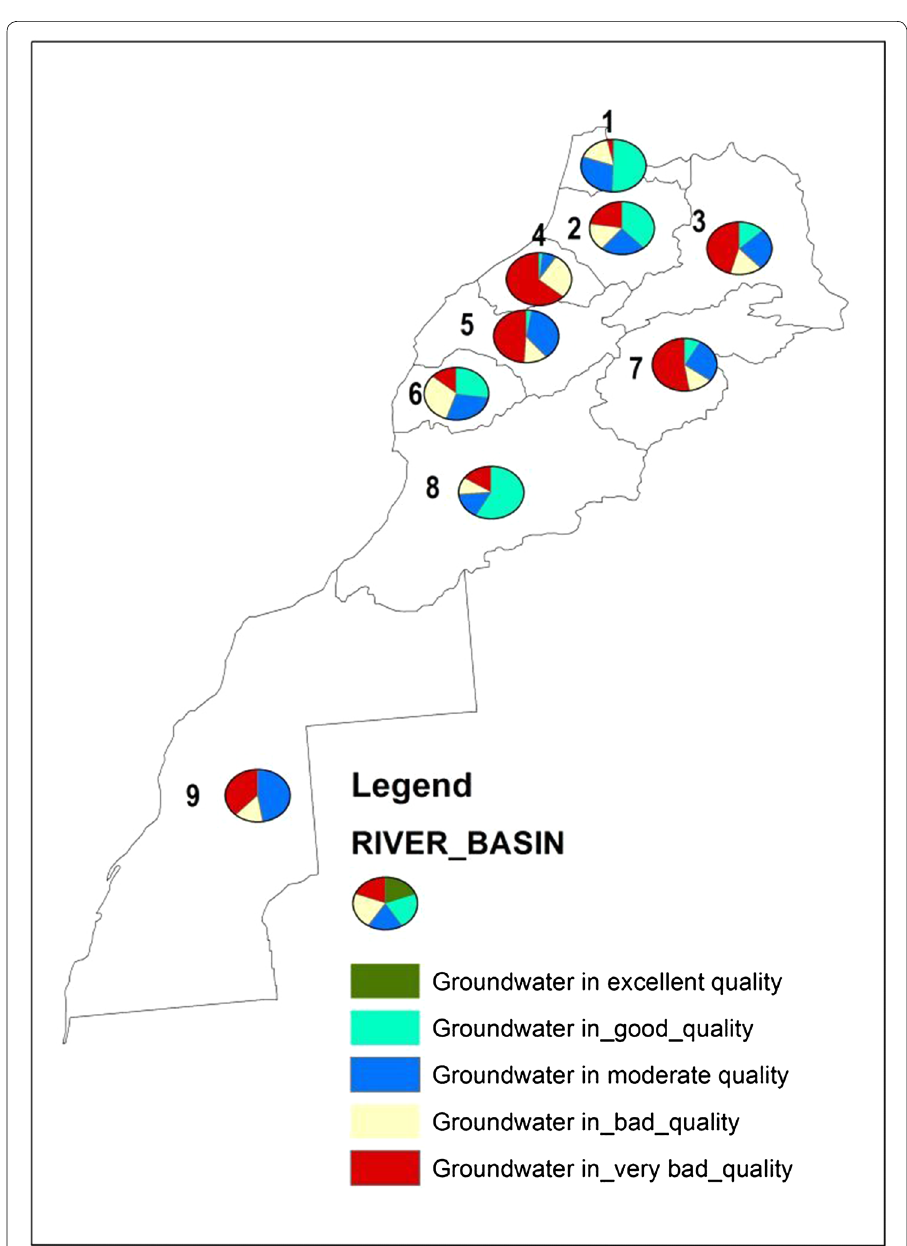
Fig. 1 Groundwater resources quality. Source : created by the authors with data extracted from MEMWE report